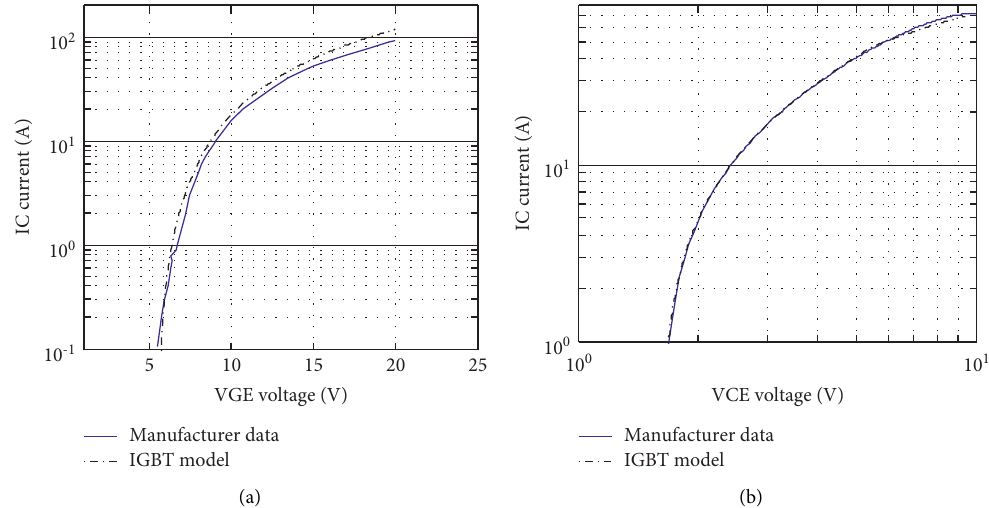
Figure 11: Experimental (manufacturer data) and simulated static characteristics of the commercial IGBT IRGBC20U, obtained for test conditions of the manufacturer. (a) Transfer characteristic. (b) Output